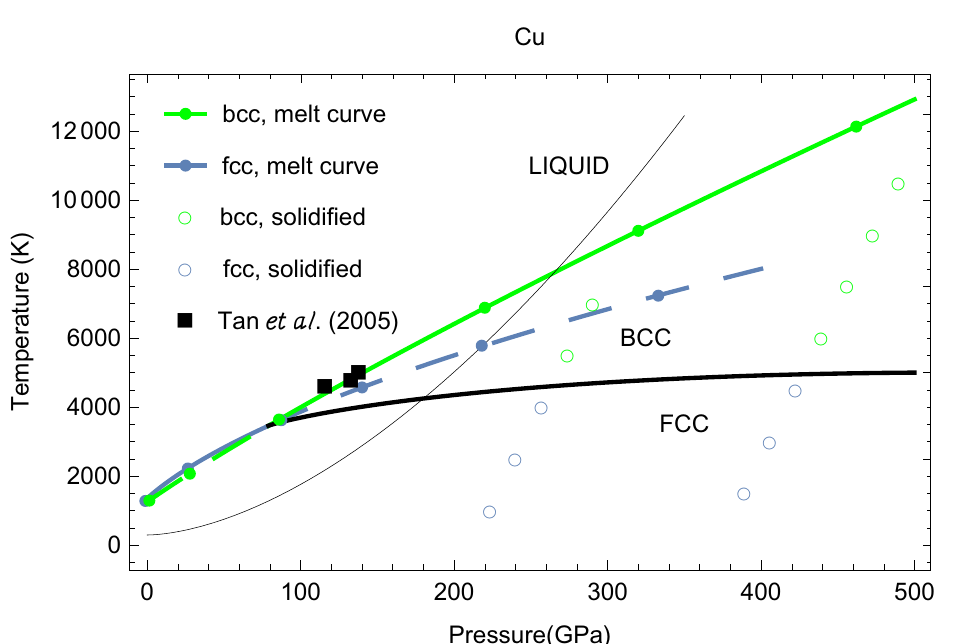
Figure 7. The ab initio phase diagram of Cu. Three experimental points (filled circles) are from ref. [43]. The fcc-bcc solid–solid phase transition boundary (black curve) is estimated based on the results of the inverse Z method simulations of the solidification of liquid Cu into fcc and bcc solid structures on other sides of the boundary. The principal Hugoniot of Cu is also shown as a thin black